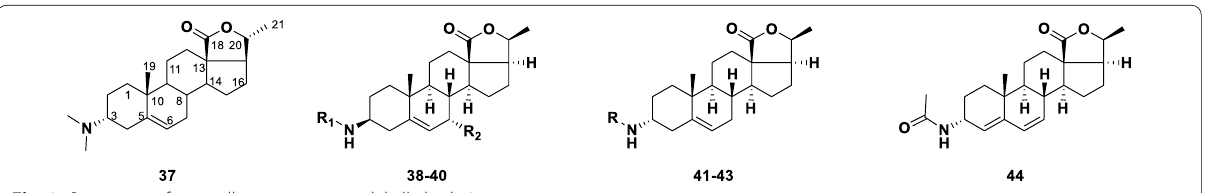
Fig. 3 Structures of paravallarine type steroidal alkaloids